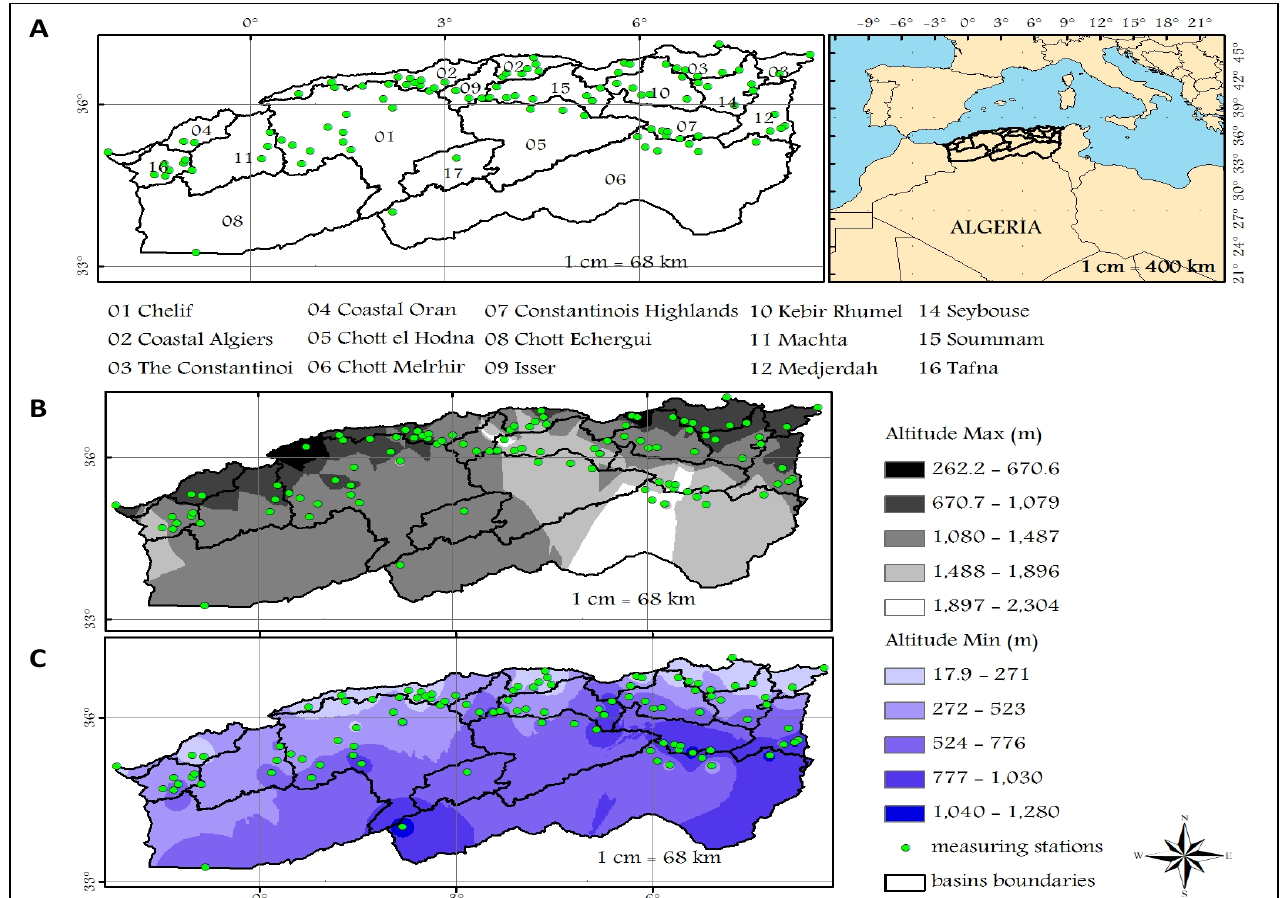
Figure 1. Maps of the northern Algeria region ( A ) and elevation variation ( B , C ) of 16 watersheds, showing the hydrometric stations ’ locations.